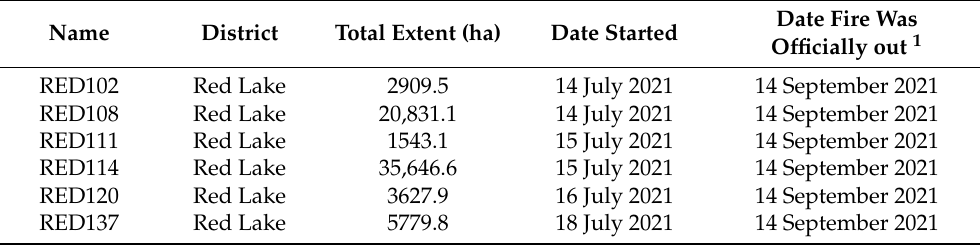
Table 3. Sample of wildfire durations and range in Northwestern Ontario obtained from the Ontario Ministry of Natural Resources and Forestry open-access data